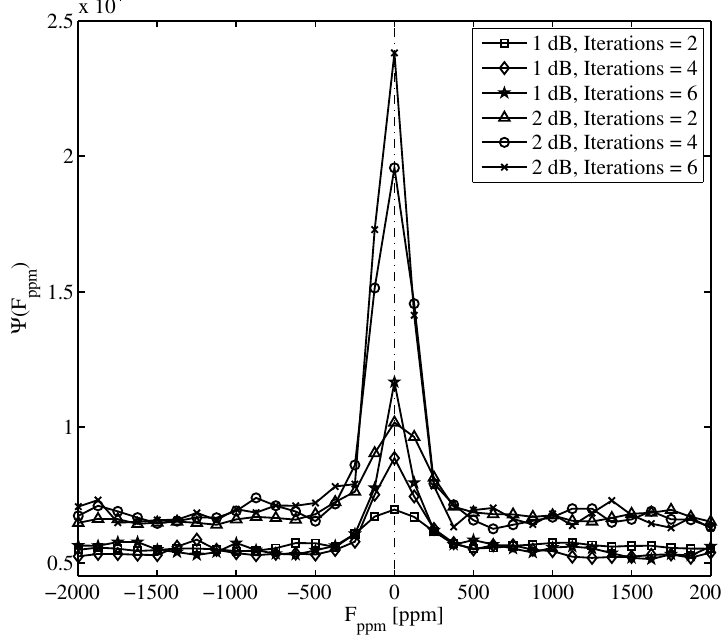
Figure 5. Partial curves of Ψ ( 0, υ ) to υ with two, four, and six iterations. Here, we define the normalized mean square error (NMSE) simulations for ( τ , υ ) as NMSE τ and NMSE υ in Equations (38) and (39)